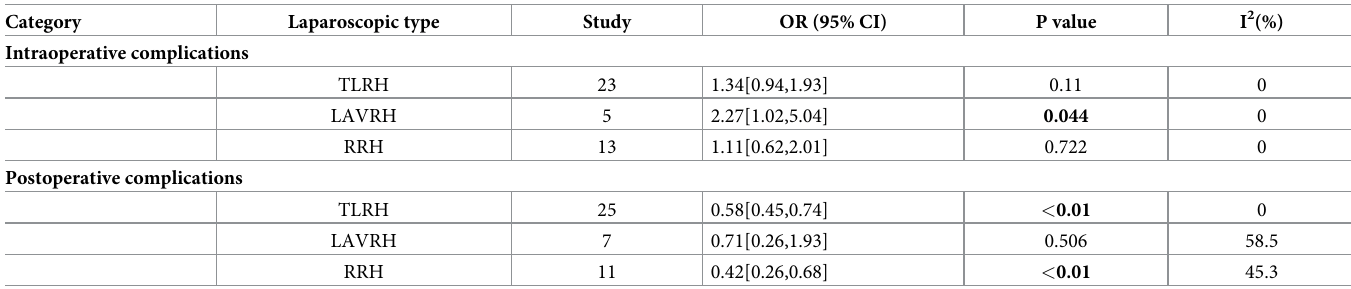
Regarding postoperative complications, our meta-analysis found that MIS was associated with significantly lower risk of postoperative overall complications compared with ORH. In individual postoperative complications, incisional hernia and lymphocyst had no differences between MIS and ORH. MIS was superior to ORH in terms of wound infection, pelvic infec- tion and abscess, lymphedema, intestinal obstruction, pulmonary embolism, and urinary tract infection, whereas the risk of fistula complications was significantly increased, with MIS com- pared to ORH. Interestingly, in a stratified analysis of fistula complications, we found that there were no significant differences in risk for four types of fistula complications. Possible rea- sons for this result including individual fistula complication had small sample size and